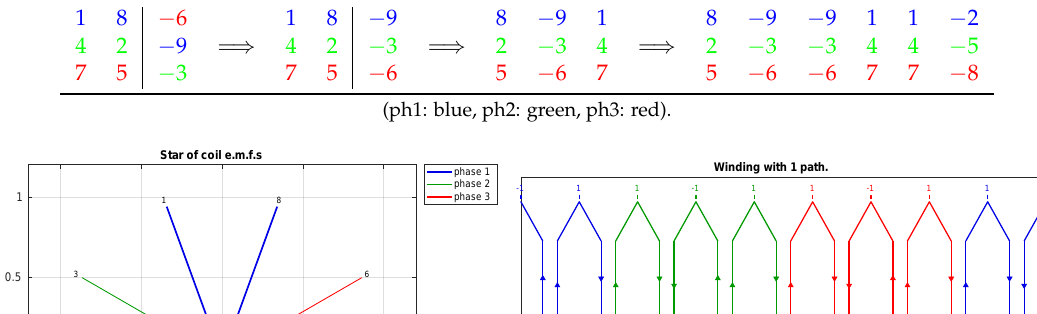
Table 11. WDT for a double-layer, three-phase concentrated winding with N = 9 and p = 4.